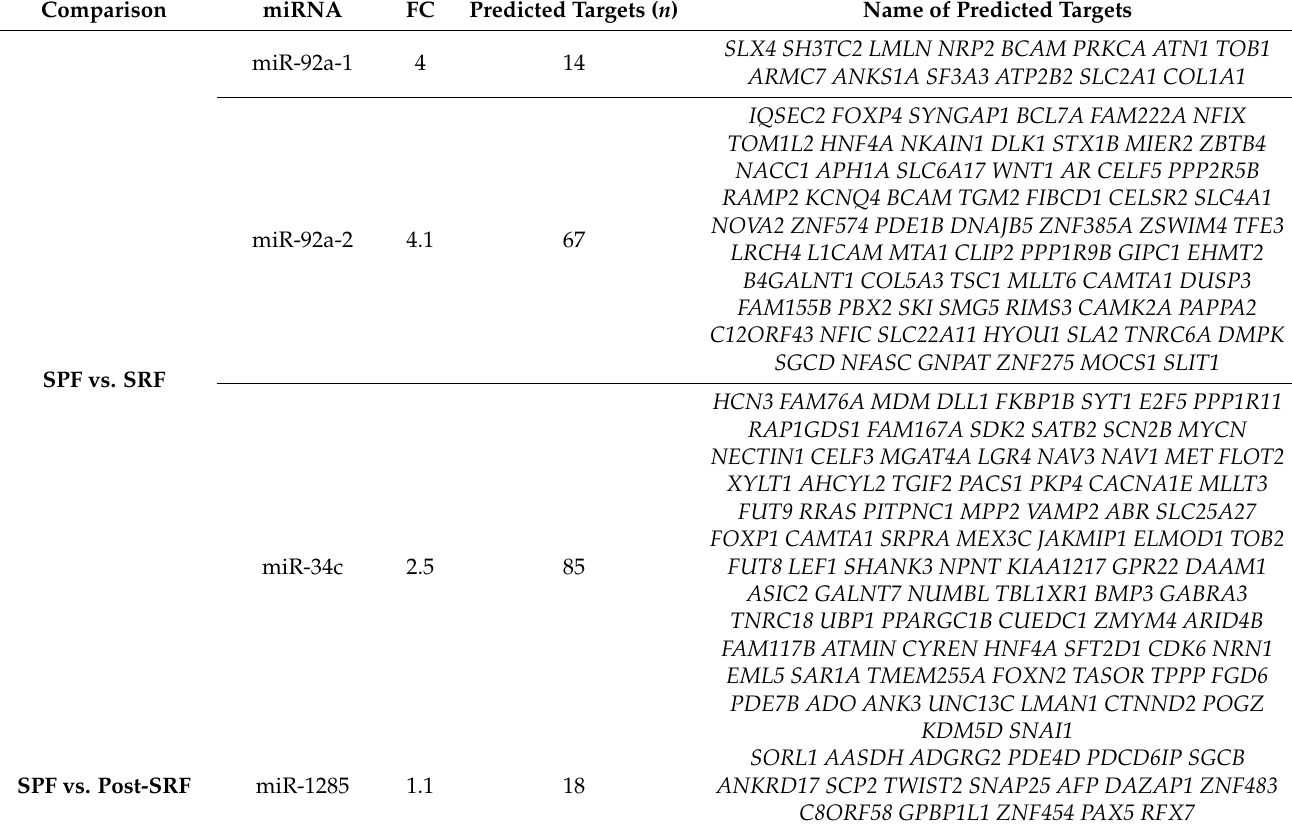
Table 4. List of predicted target genes of differentially expressed miRNAs ( p value < 0.05 and >1.0-Fold Change (FC) or < − 1.0-FC) in spermatozoa from three different ejaculate fractions: sperm peak fraction (SPF), sperm rich fraction (SRF), or post-SRF, or from the epididymal terminal segment (EpiTS). Comparison miRNA FC Predicted Targets ( n